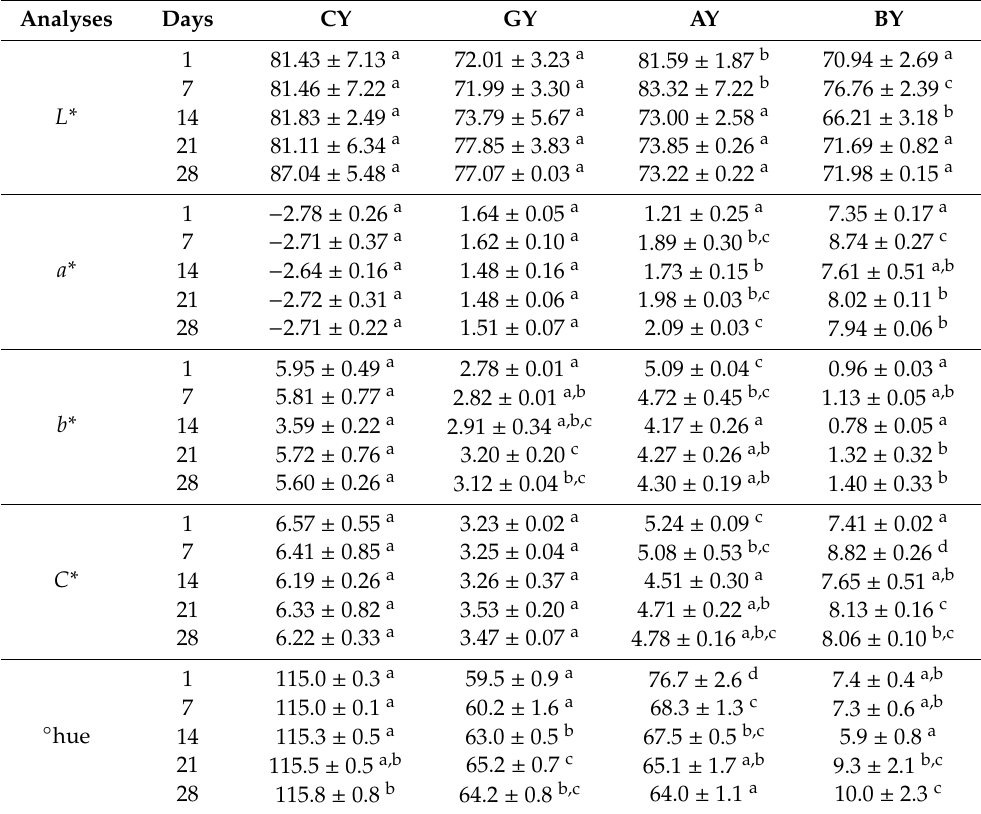
Table 4. E ff ect of storage on color characteristics of